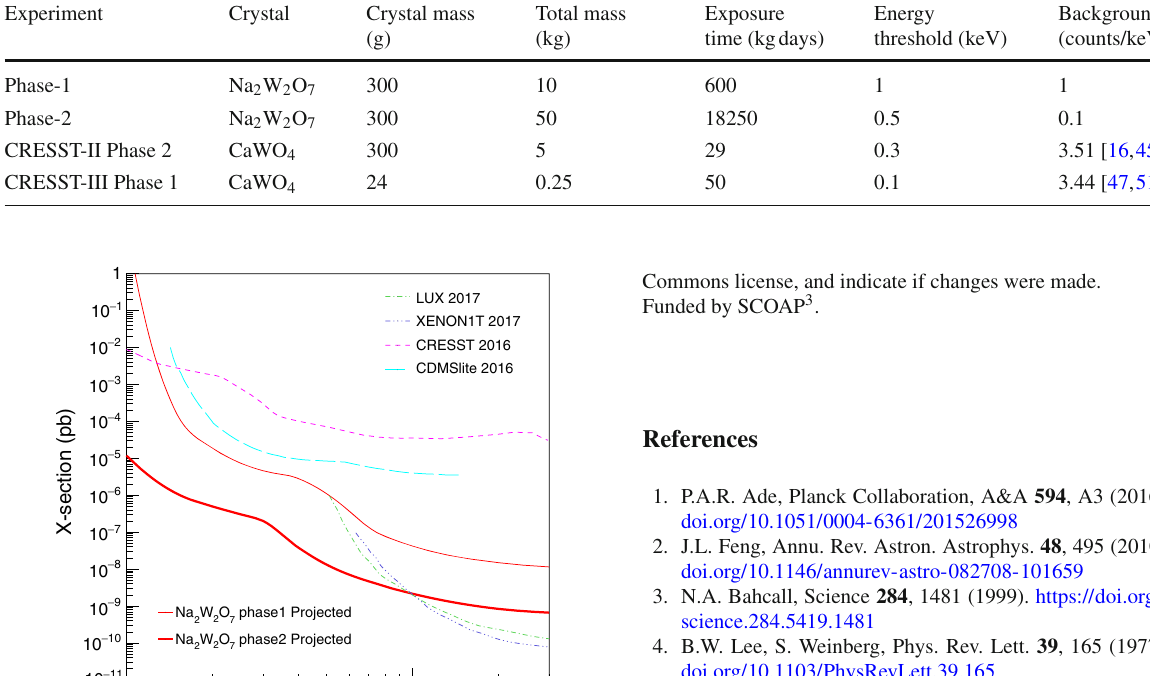
Table 1 Summary table of assumed parameters for two different phase of experiment, which is compared with CRESST parameter Experiment Crystal Exposure